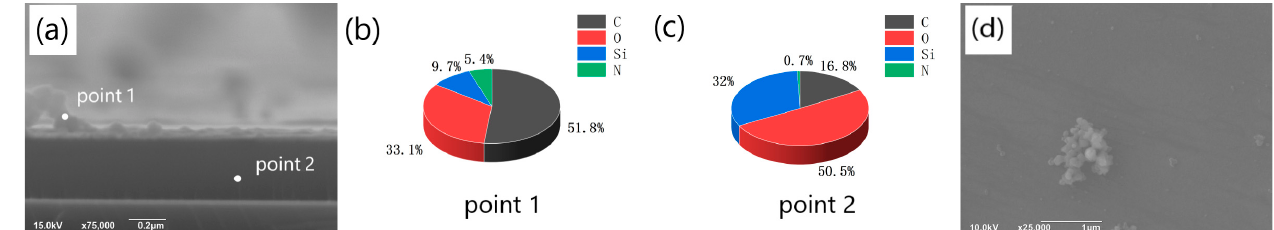
Figure 1. ( a ) SEM image of the cross-section of the film obtained on the silicon dioxide substrate and EDS detection position (point1 corresponds to the cross-section of the film, point2 corresponds to the cross-section of the substrate); ( b ) the proportion of different elements at the film cross-section (point1); ( c ) The proportion of different elements at the cross section of the substrate (point2); ( d ) SEM image of the aggregates on the fi lm surface.